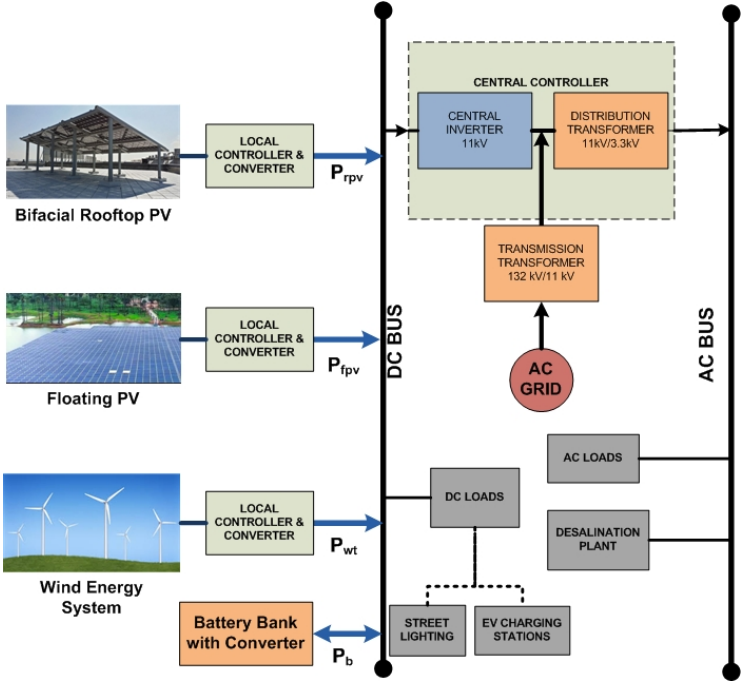
Figure 3. Block diagram of the proposed hybrid renewable energy system.